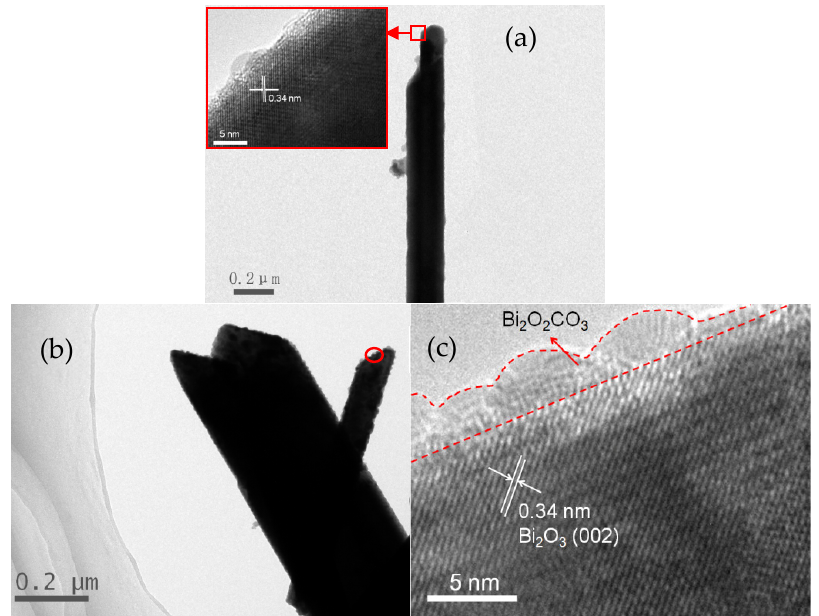
Figure 6. TEM images of ( a ) α -Bi 2 O 3 microtubes (insert: HRTEM) and ( b ) Bi 2 O 2 CO 3 / α -Bi 2 O 3 microtubes; an HRTEM image of ( c ) Bi 2 O 2 CO 3 / α -Bi 2 O 3 microtubes.